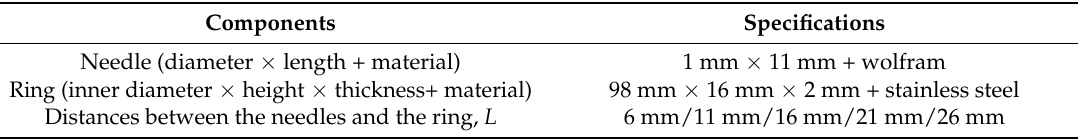
Table 1. Specifications of the